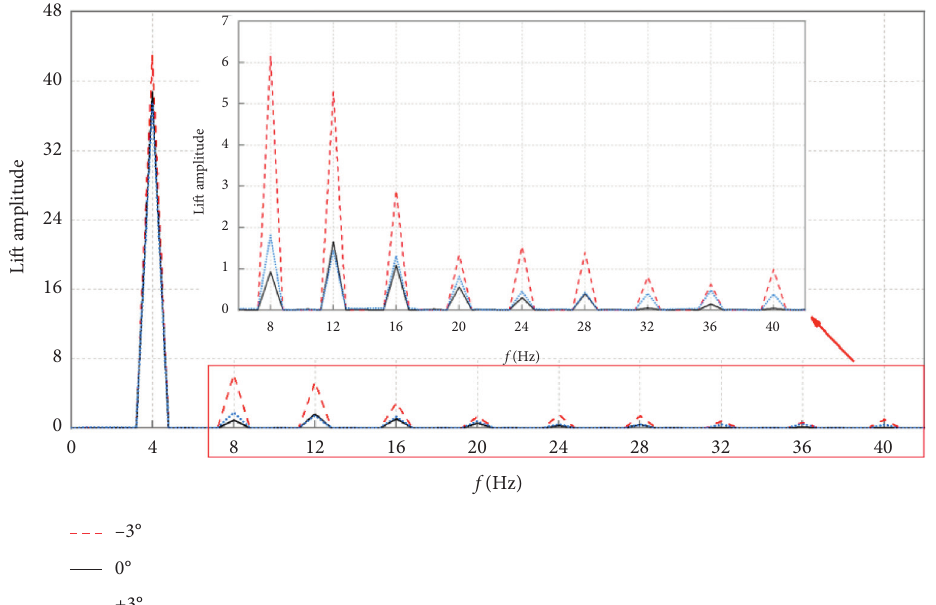
Figure 19: Aerodynamic lift spectrum under single frequency pitching motion of large